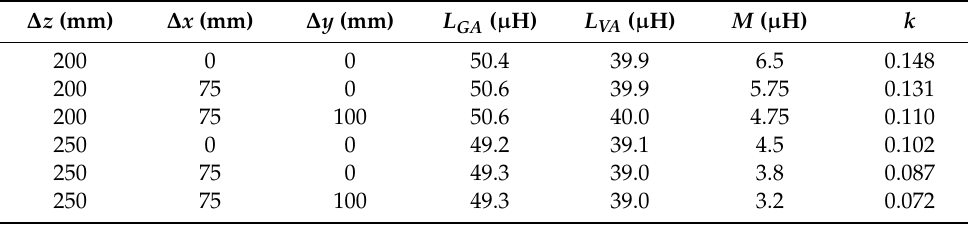
Table 2. Calculated lumped parameters of the considered WPT coils.